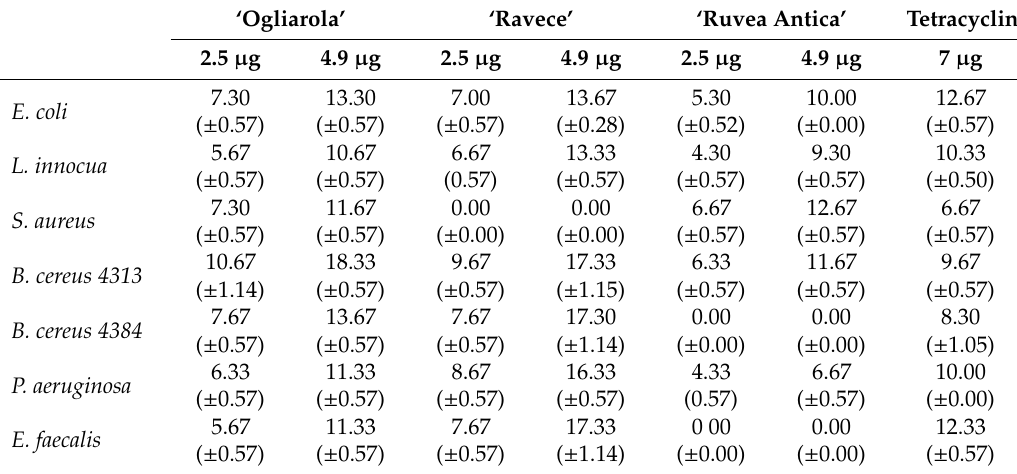
Table 1. Antibacterial activity evaluated through the inhibition zone test of the three polyphenol (PF) extracts of Ogliariola , Ravece and Ruvea antica EVOOs, against di ff erent pathogens. The test was performed using 2.5 and 4.9 µ g of extract. Data are expressed in mm. Results are shown as mean ( ± SD) ( n = 3). For details, see Materials and Methods.